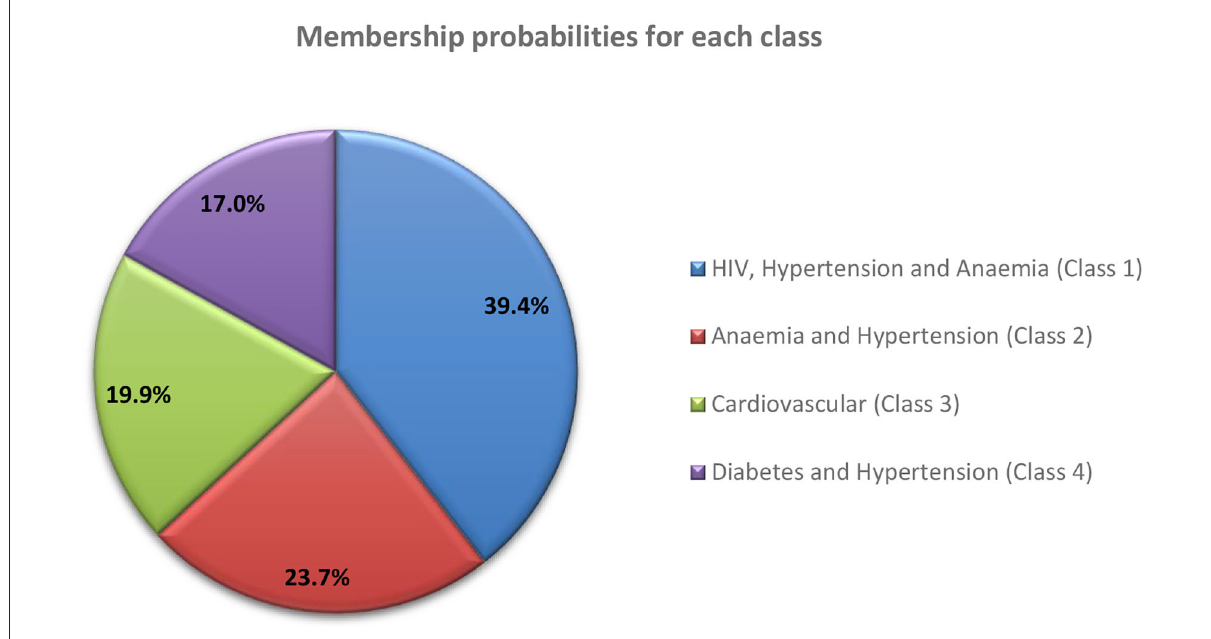
FIGURE2 Membership probabilities for each latent class.